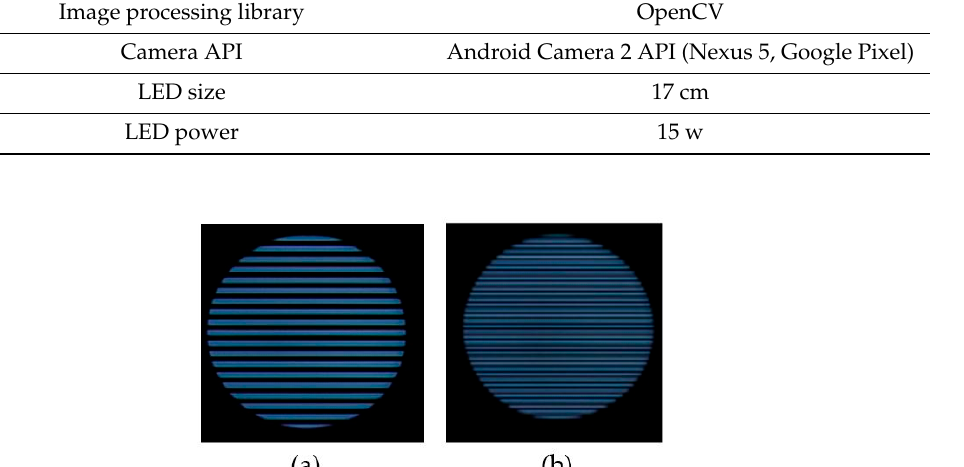
Figure 21. Rolling shutter image of 2FSOOK. ( a ) 2 kHz signal. ( b ) 4 kHz signal.